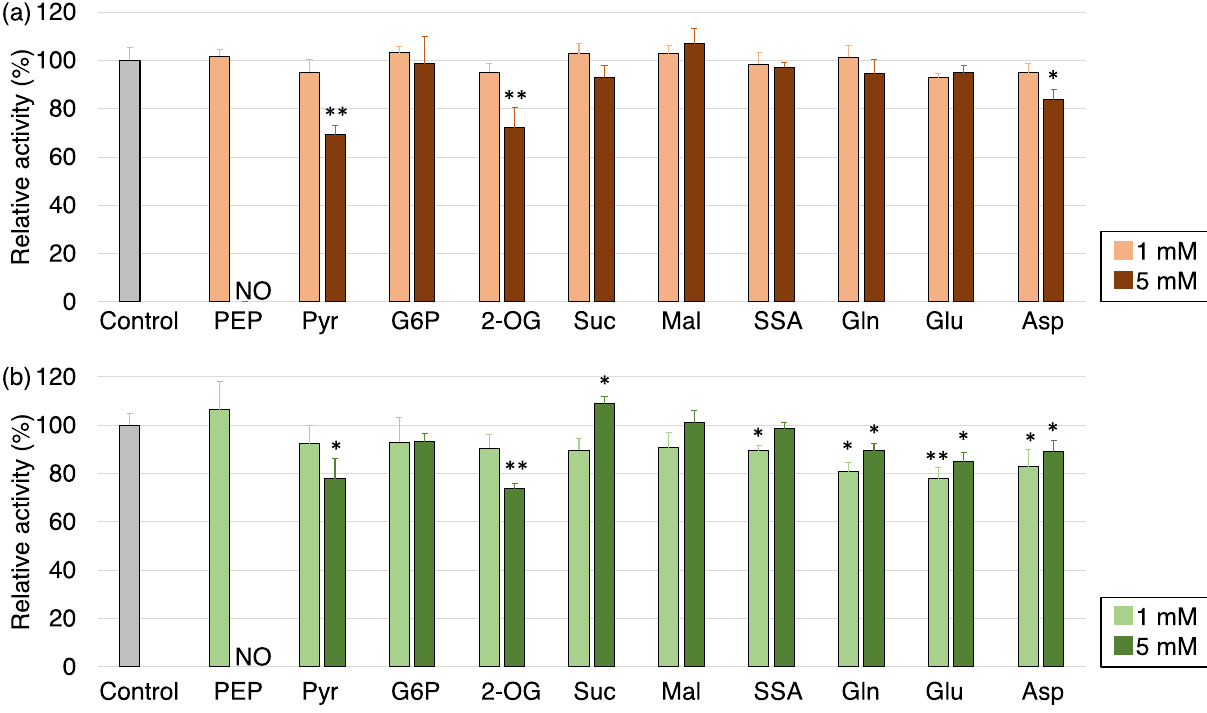
Figure 5. Effect of other TCA metabolites on the activity of Sy AcnB. The effect was analysed using ( a ) 1.13 mM trisodium citrate dihydrate and Tris–HCl buffer pH 7.7 at 45 °C and ( b ) 1.54 mM dl-isocitrate trisodium salt hydrate and Tris–HCl buffer pH 8.0 at 53 °C. Mean ± SD values were calculated from three independent experiments. The asterisks indicate significant differences compared to the Sy AcnB activities at the control condition (Student’s t -test; * P < 0.05, ** P < 0.005). Sy AcnB, Synechocystis sp. PCC 6803 aconitase B; SD, standard deviation; NO, no enzymatic activity was detected; PEP, phosphoenolpyruvic acid monopotassium salt; Pyr, sodium pyruvate; G6P, glucose 6-phosphate; 2-OG, 2-oxoglutarate; Suc, disodium succinate; Mal, sodium l-malate; SSA, succinic semialdehyde; Gln, l-glutamine; Glu, l-glutamate; Asp, sodium l-aspartate